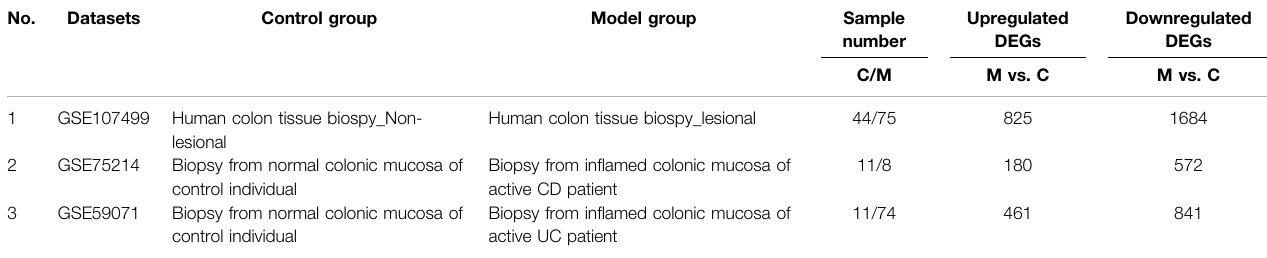
TABLE 1 | DEGs in colon tissue or mucosa of IBD from GEO datasets. No.